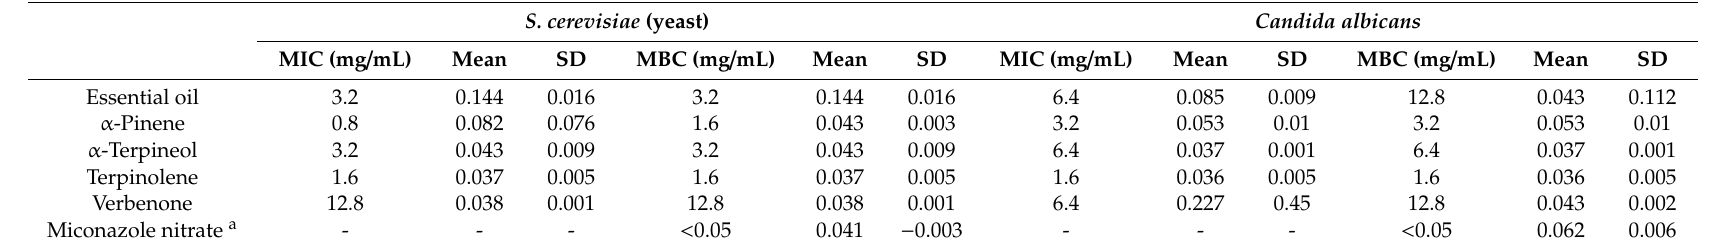
Table A3. Antifungal activities of SEO and the major